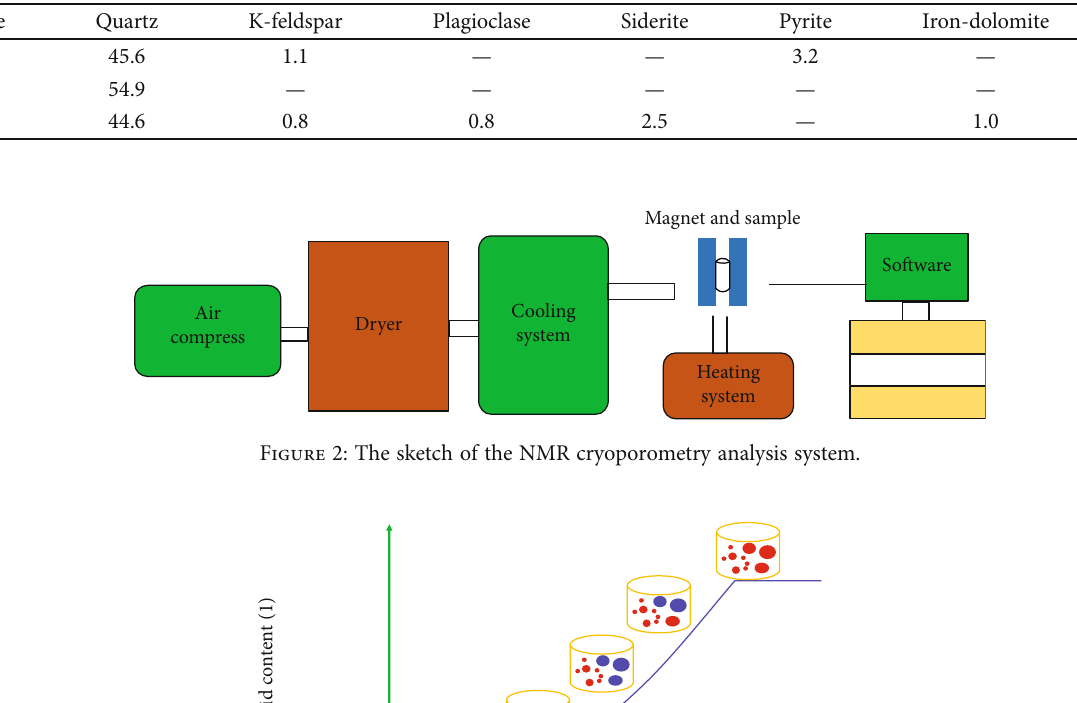
(Figure 4(i)), and fi lamentous or fl aky illite (Figures 4(h) and 4(i)). Clay-dominated pores are distributed in fi lamen- tous and platey illite and range between 1 and 4 microns three samples (Figures 4(b), 4(e), and 4(g)). As can be seen from Figure 4, residual interparticle pores and clay- gas formation. SEM observations indicate that microfrac- have seen in tight oil sandstones [13]. from Figure 5, NMR T distributions of three tight gas sand- 2 stone samples all show three peaks, marked as P1, P2, and P3. Three peaks, respectively, range around 0.3 ms, 10 ms,